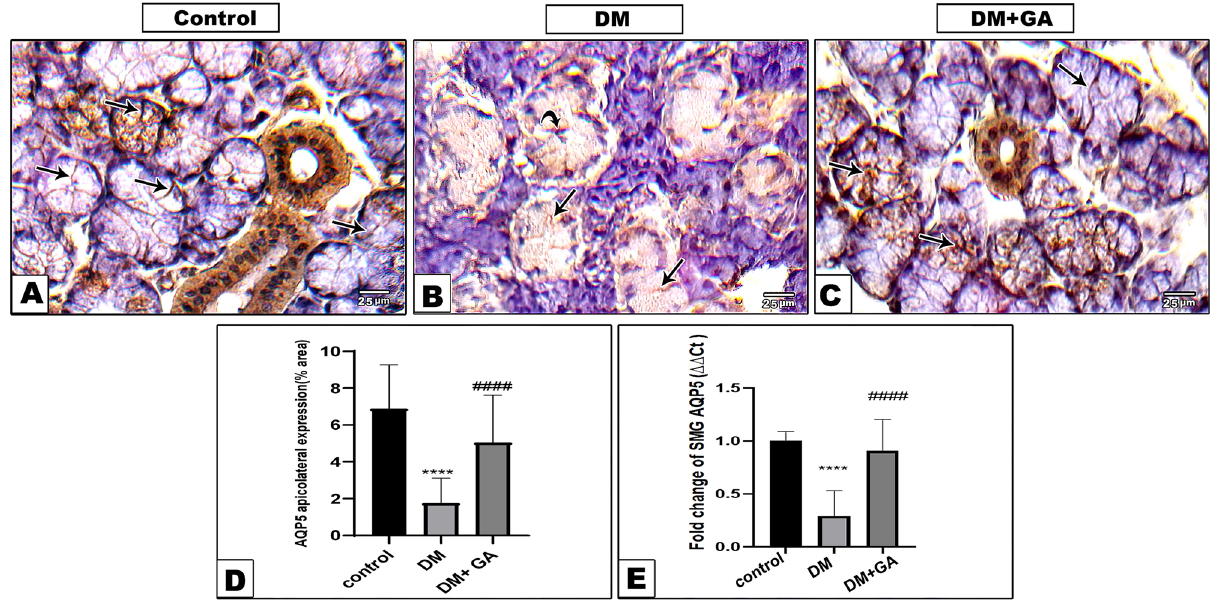
Figure 6. AQP5 immunostained sections of SMG shows, apicolateral localization (arrow) in control ( A ), and GA ( C ) groups, with apparent degradation and cytoplasmic translocation in DM (curved arrow) and little apicolateral expression (arrow) ( B ) (AQP5, IHC, × 40)). ( D ) Quantitative analysis of AQP5 immunostaining (%area) and fold change of AQP5 gene expression ( E ), Data were expressed in mean ± SE. P < 0.05 is considered significant. ****Significant compared to control group at P < 0.001, #### Significant compared to diabetic group at P <